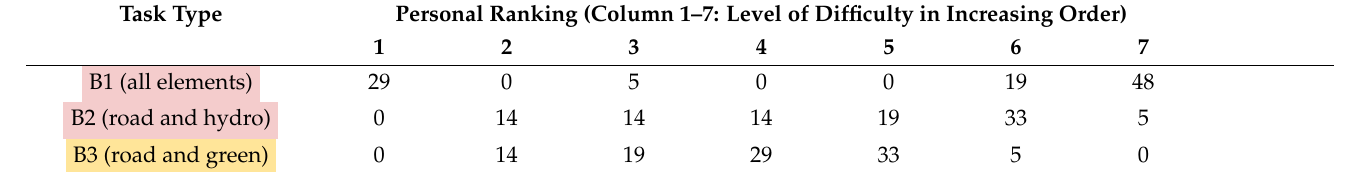
Table 5. Experts’ and novices’ self-reported ranking of task difficulty. Results are presented as percentages and each row adds up to 100%. For instance, 48% of the experts thought Block 1 was the hardest. Objectively hard tasks marked with red highlight (B1 and B2), moderate in orange/yellow (B3 and B4) and easy ones in green (B5, B6 and B7). Highest scores are highlighted in gray.